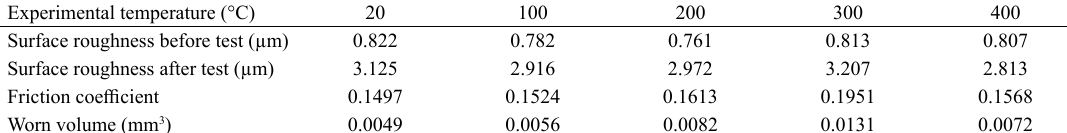
Table 3. The friction and wear experimental data for the 9Cr18Mo sample when rubbed by the ceramic frictional pair. Experimental temperature (°C)